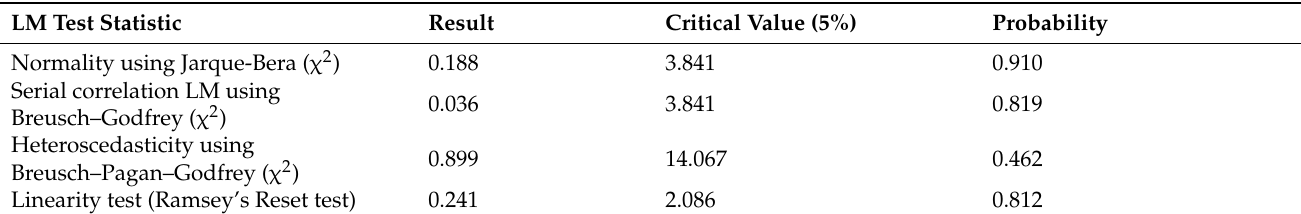
Table 8. ARDL diagnostic test.